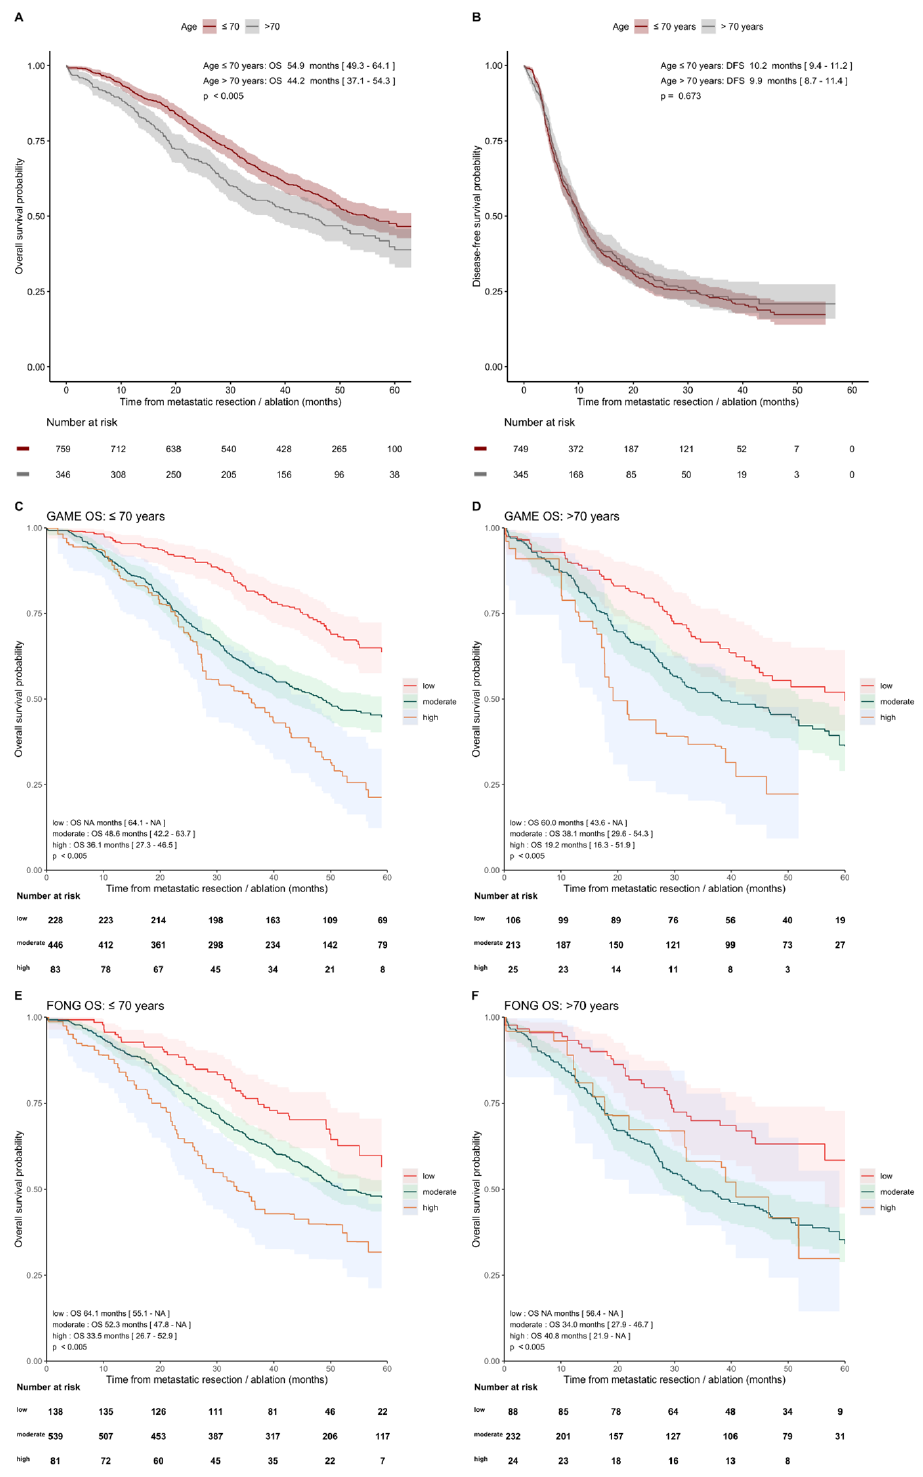
Figure 4. Kaplan–Meier analysis showing OS and DFS curves in patients with age ≤ 70 years and >70 years for the GAME and Fong risk categories. ( A ) OS and ( B ) DFS in patients with age ≤ 70 years and >70 years. Subsequently, the OS outcomes of the GAME risk categories were analyzed in the subgroup ≤ 70 years ( C ) and >70 years ( D ) and of the Fong risk categories in subgroups of patients ≤ 70 years ( E ) and >70 years ( F ).